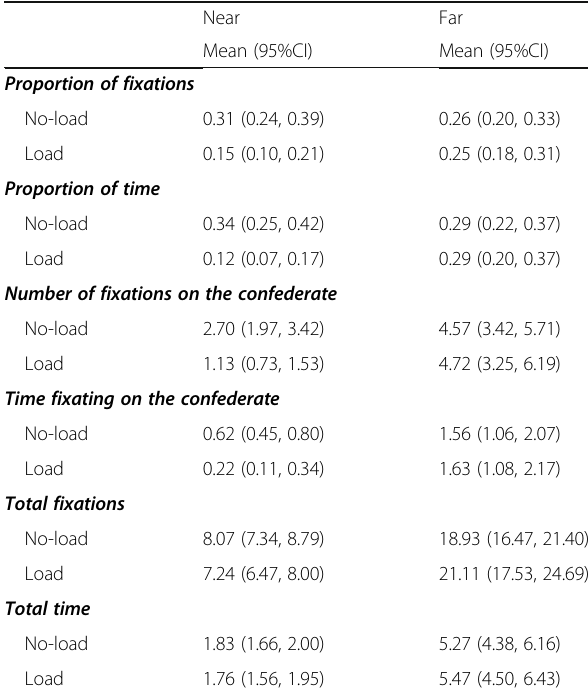
Table 4 Fixation behavior toward the confederate by Condition (no-load, load) and Proximity (near, far) in Experiment 2; time is reported in